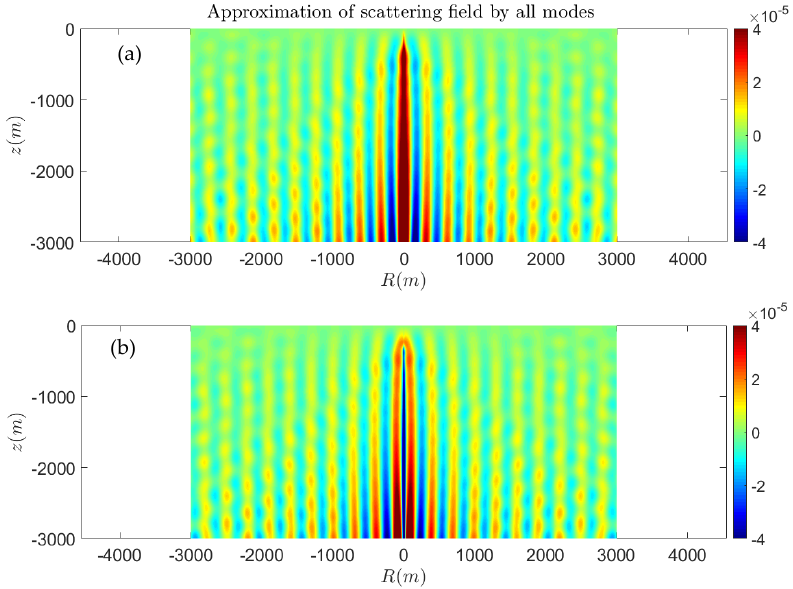
Figure 18. ( a ) Real and ( b ) imaginary parts of the scattering field p scat = G I − G N